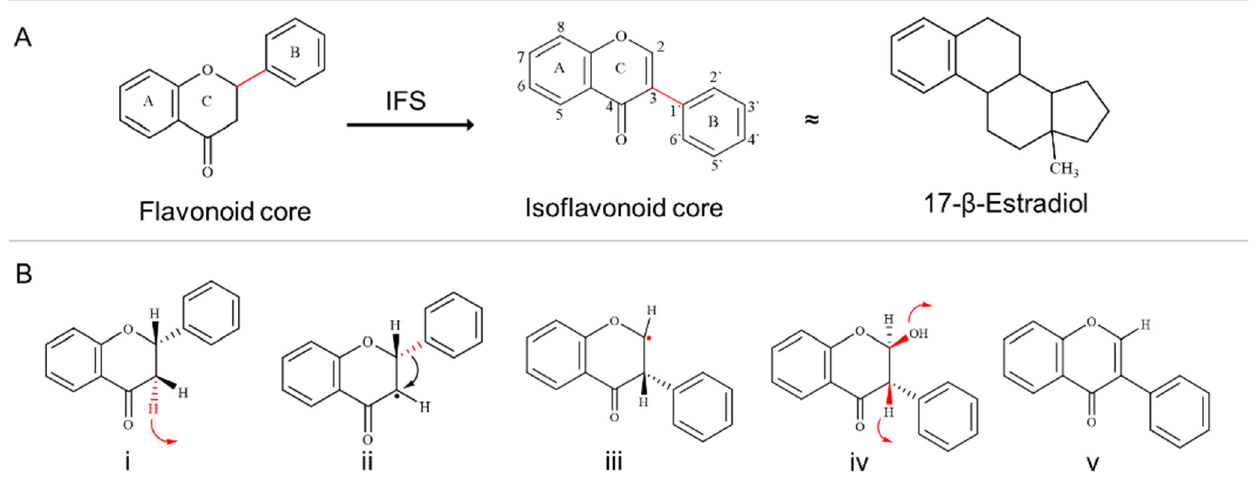
Figure 1. Basic structure of isoflavonoid and aryl ring migration reaction mechanism. ( A ) B-ring is attached at the C3 position in isoflavonoids, making them different from flavonoids and similar to the human estrogen hormone (17- β -Estradiol). ( B ) The aryl ring migration reaction can be divided into five steps (Red colour represents the site of reactivity). (i) A H atom from the C3 position is removed (red arrow represents the removal of H), (ii) which is followed by the migration of the aryl ring from C2 to the C3 position. (iii) Due to aryl ring migration, C2 becomes electron-deficient, which is (iv) stabilised with the addition of the OH group, (v) A dehydration step that either occurs spontaneously or with the help of 2-hydroxyisoflavonid dehydratase (HIDH) completes the reac- tion. Step i to iv are catalysed by IFS. IFS: Isoflavonoid Synthase.